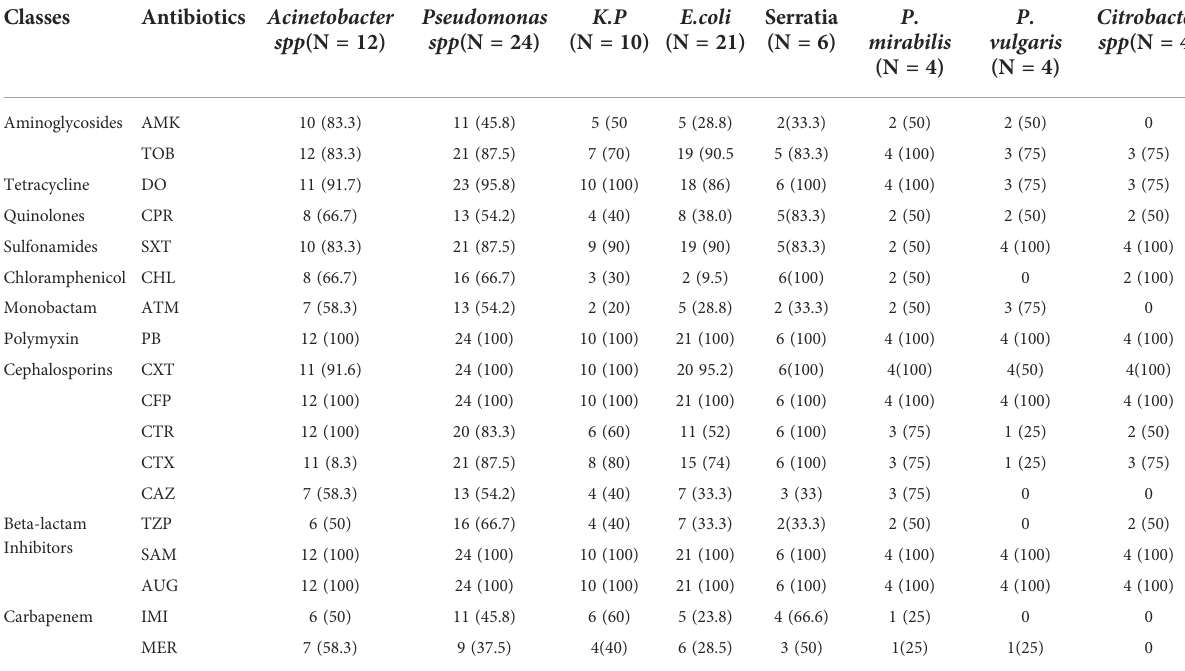
TABLE 5 Resistance pattern of gram-negative